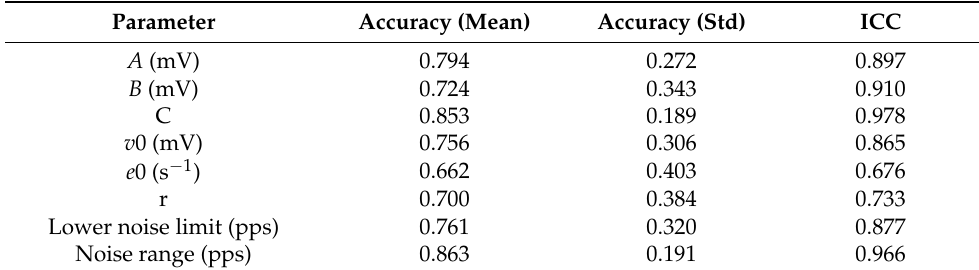
Table 3. Accuracy and repeatability results.